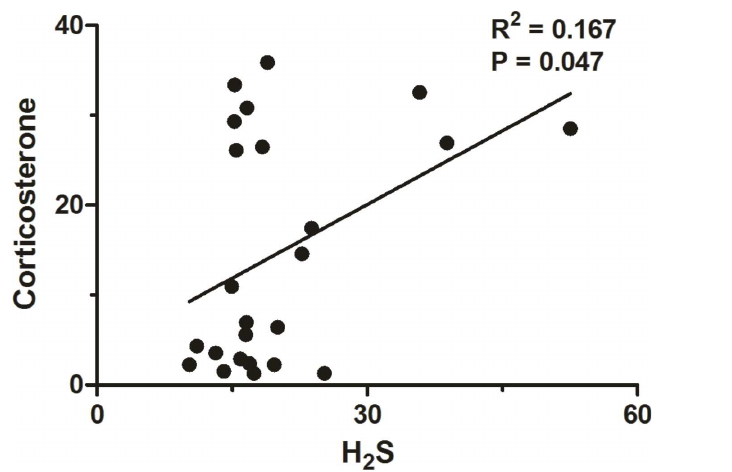
Fig 7. Correlation analysis between H 2 S and